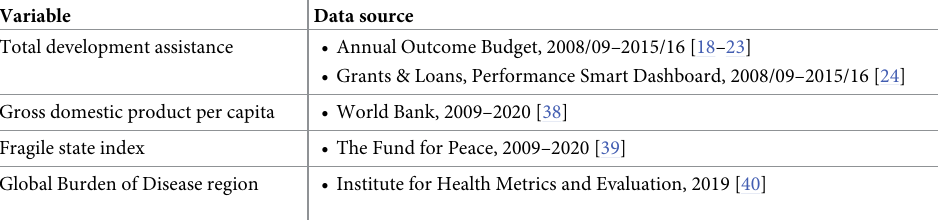
Table 2. Variables and data sources used for imputing DAH for select recipient